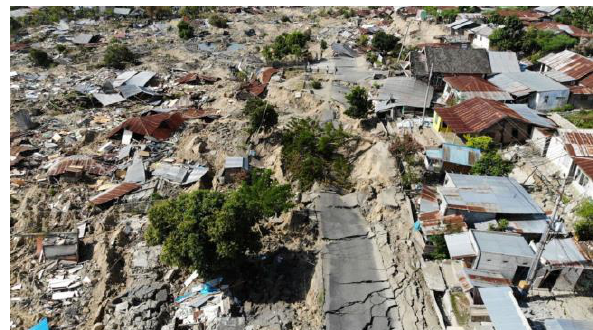
Figure 5. An example to liquefaction from Palu, Indonesia, occurred after September 28, 2018 earthquake, where shaking of the ground has caused roads to break up and houses to be swallowed (ref: news.sky.com).